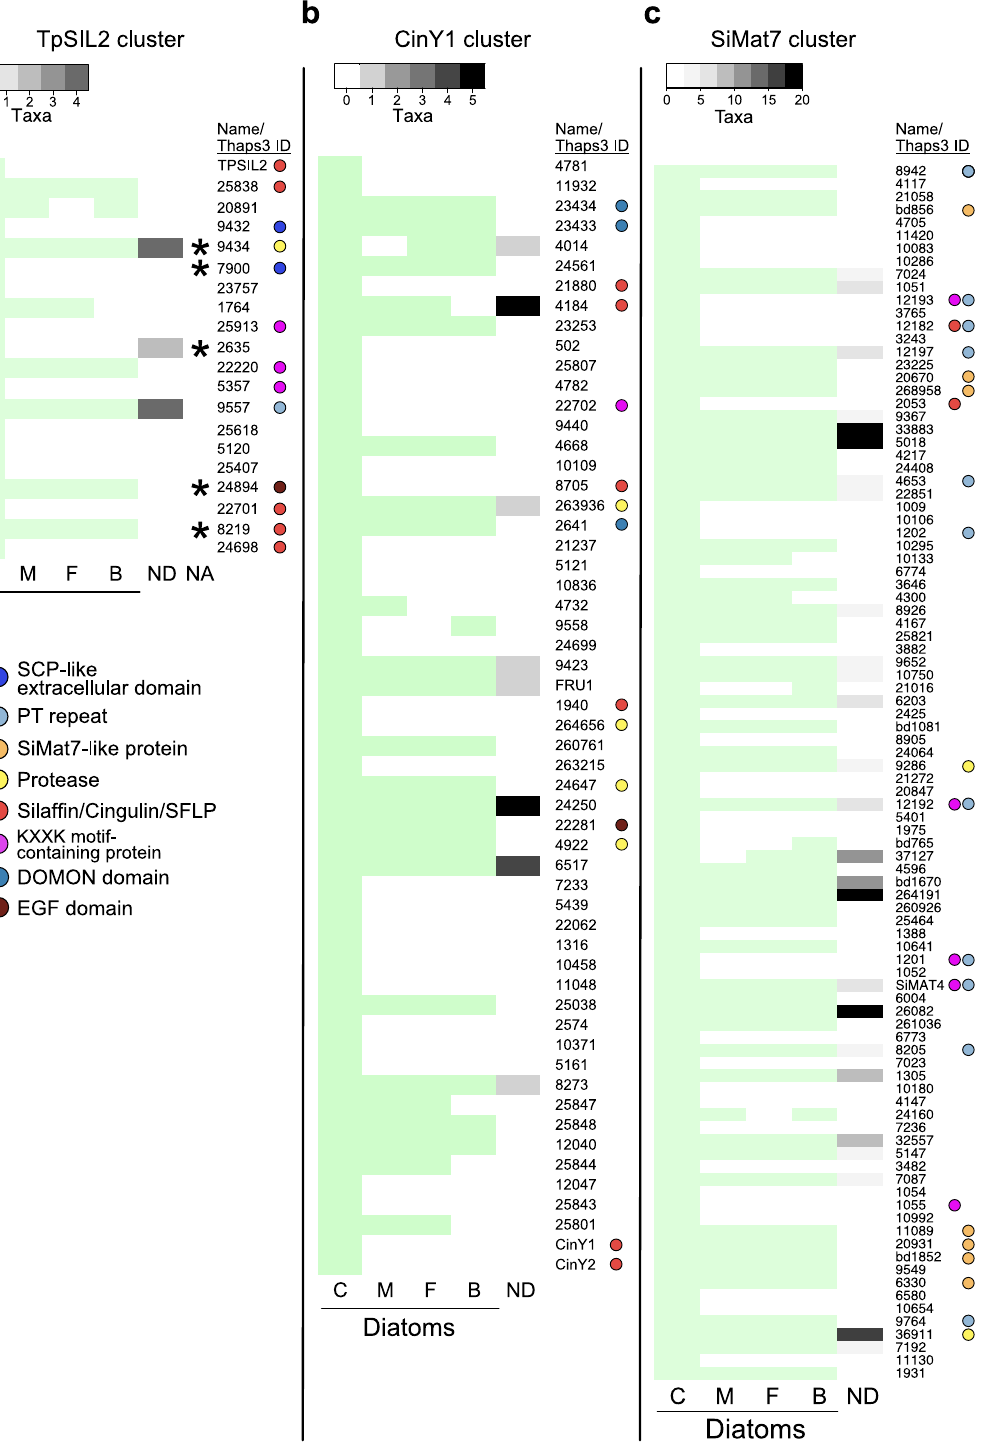
Figure 6. Genes in the Si-responsive gene clusters are poorly conserved. The phylogenetic distribution of proteins included in the ( a ) TpSIL2, ( b ) CinY1 and ( c ) SiMat7 clusters were analysed on a local BLAST server using tBlastN searches. Light green rectangles indicate presence of sequences with significant score against the corresponding T. pseudonana protein (tBlastN scores < 1e–10) in each diatom class. Greyscale rectangles indicate presence of sequences with significant score in non-diatom microalgae. The greyscale heat map represents the number of species within each taxonomical class with significant score against the corresponding T. pseudonana protein. Asterisks indicate significant tBlastN scores ( < 1e–10) against non-algal sequences in the NCBI nr database. Coloured circles indicate the presence of selected known domains. Numbers indicate JGI Thaps3 gene IDs. C, Coscinodiscophyceae; M, Mediophyceae; F, Fragilariophyceae; B, Bacillariophyceae; ND, non-diatom microalgae; NA, non-algal